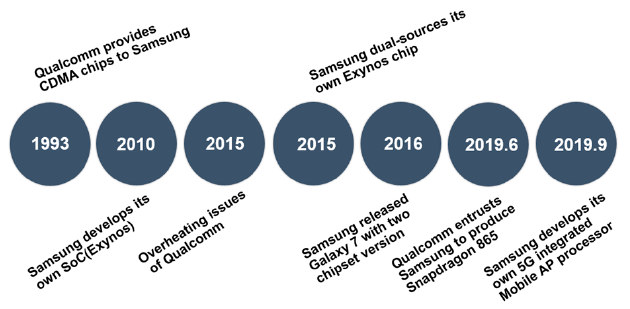
Figure 3. The history of coopetition process of Qualcomm and Samsung.